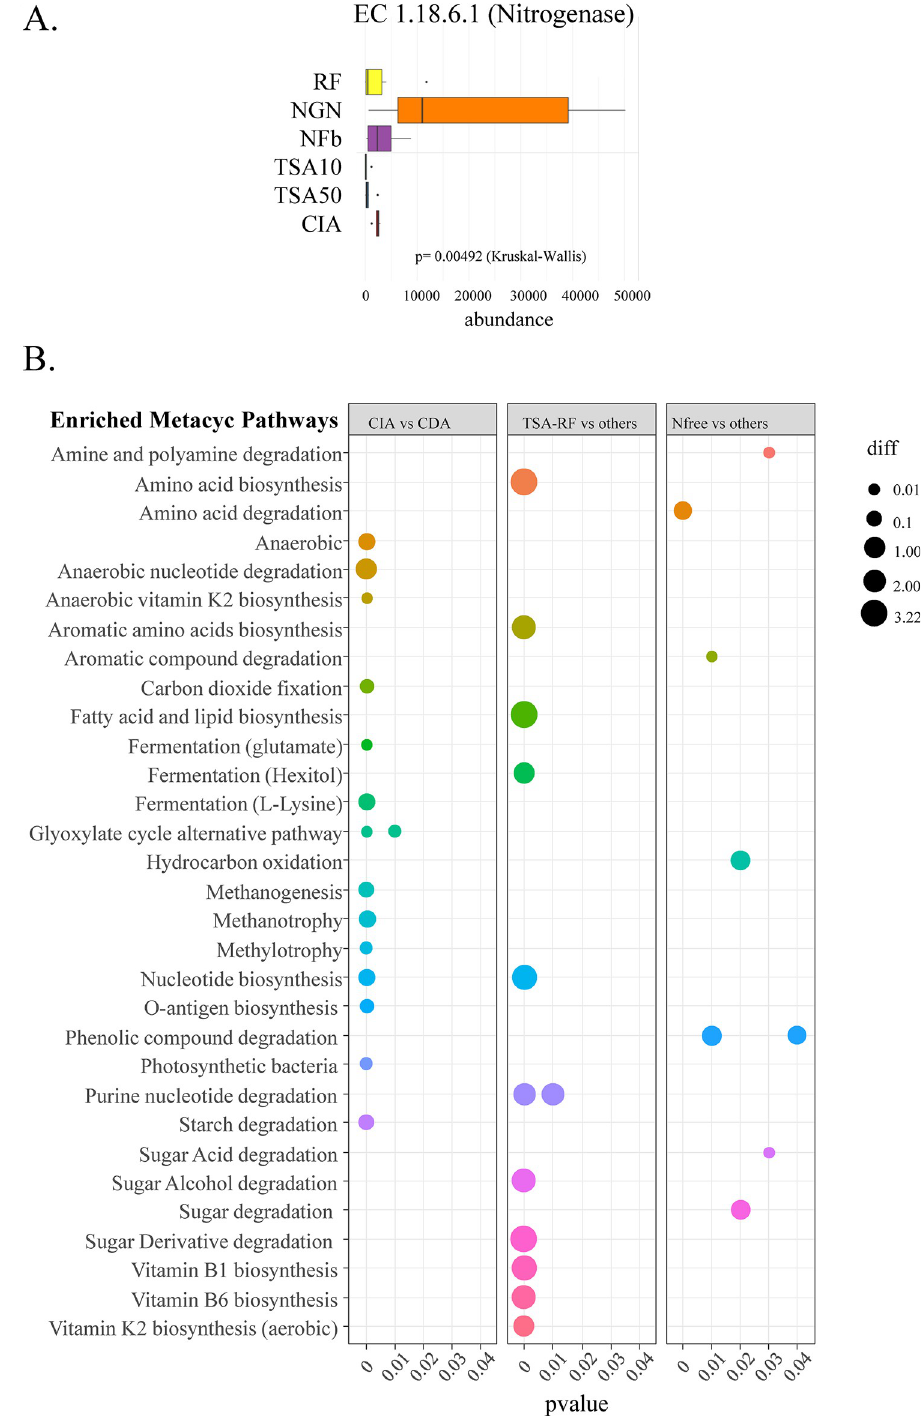
Fig 5. Predicted enriched pathways in amplicon libraries. Nitrogenase enrichment prediction in 16S amplicon libraries (A) and dot-plot of predicted enriched Metacyc pathways (B) in CIA vs CDA cross comparisons, non- selective media (TSA, RF) versus others, and nitrogen-free media versus others. Enzyme and pathway enrichment were predicted with PICRUSt2 and a differential analysis was performed with a Kruskal-Wallis test. “diff” is the abbreviation for differential analysis (see Materials &